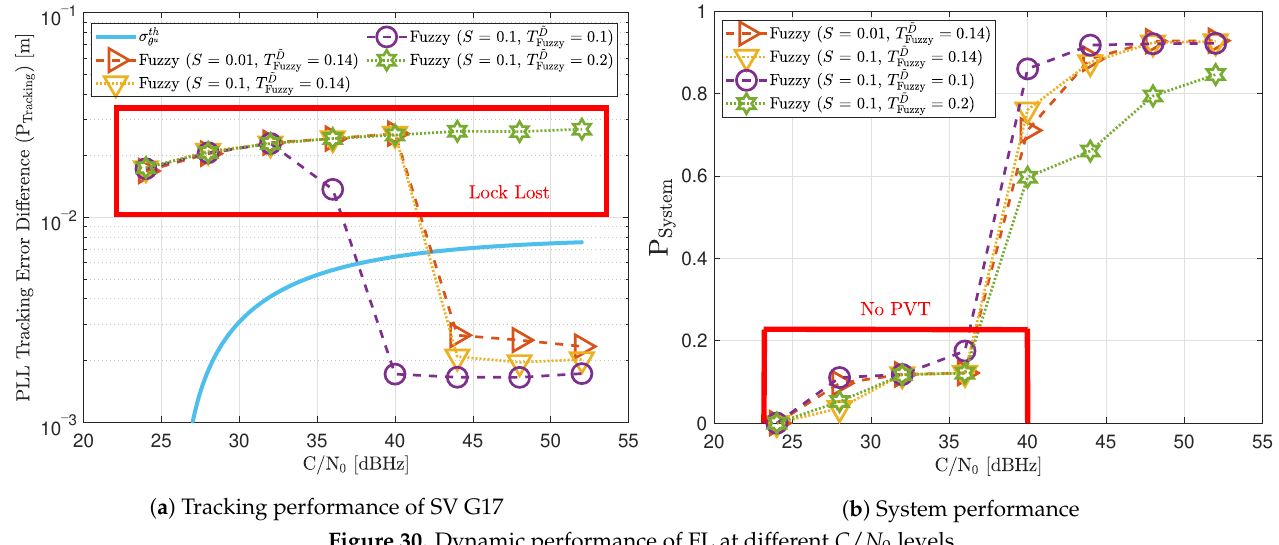
Figure 30. Dynamic performance of FL at different C / N 0 levels. Figure 31 shows how the PLL loop bandwidth adjusts during the dynamic scenario using the presented FL configurations. At 32 dBHz, all the configurations of the FL fail with tracking the signal. When the fuzzy technique with the lowest T ˜ D loses lock, unlike the Fuzzy other configurations, the loop bandwidth goes to the maximum loop bandwidth